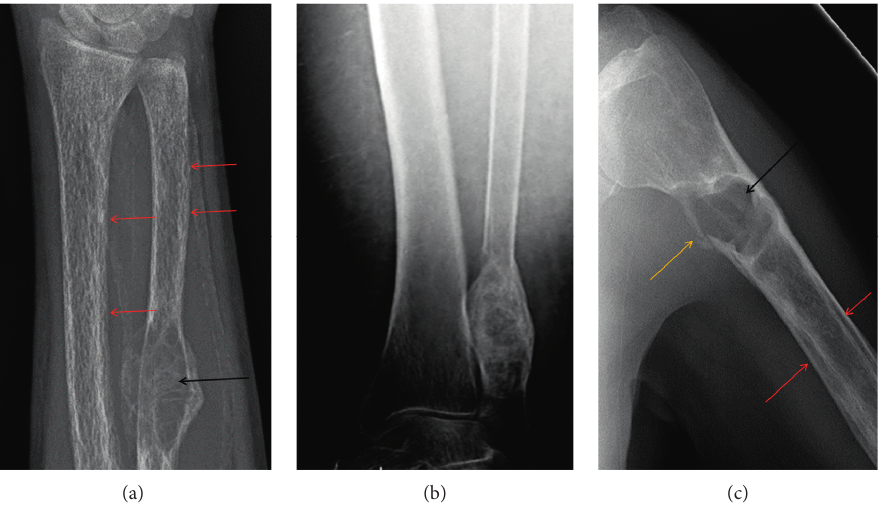
Figure 3: Additional cases of brown tumors (black arrows) in the ulna, fibula, and humerus. Prominent forearm demineralization with subperiosteal (red arrows), intracortical, and trabecular resorption in the forearm bones and humerus with resultant appearance of coarse internal trabeculation. Pathologic fracture at the humerus brown tumor (yellow arrow) and intracortical resorption with cigar/oval-shaped or tunnel-shaped radiolucency in the cortex (red